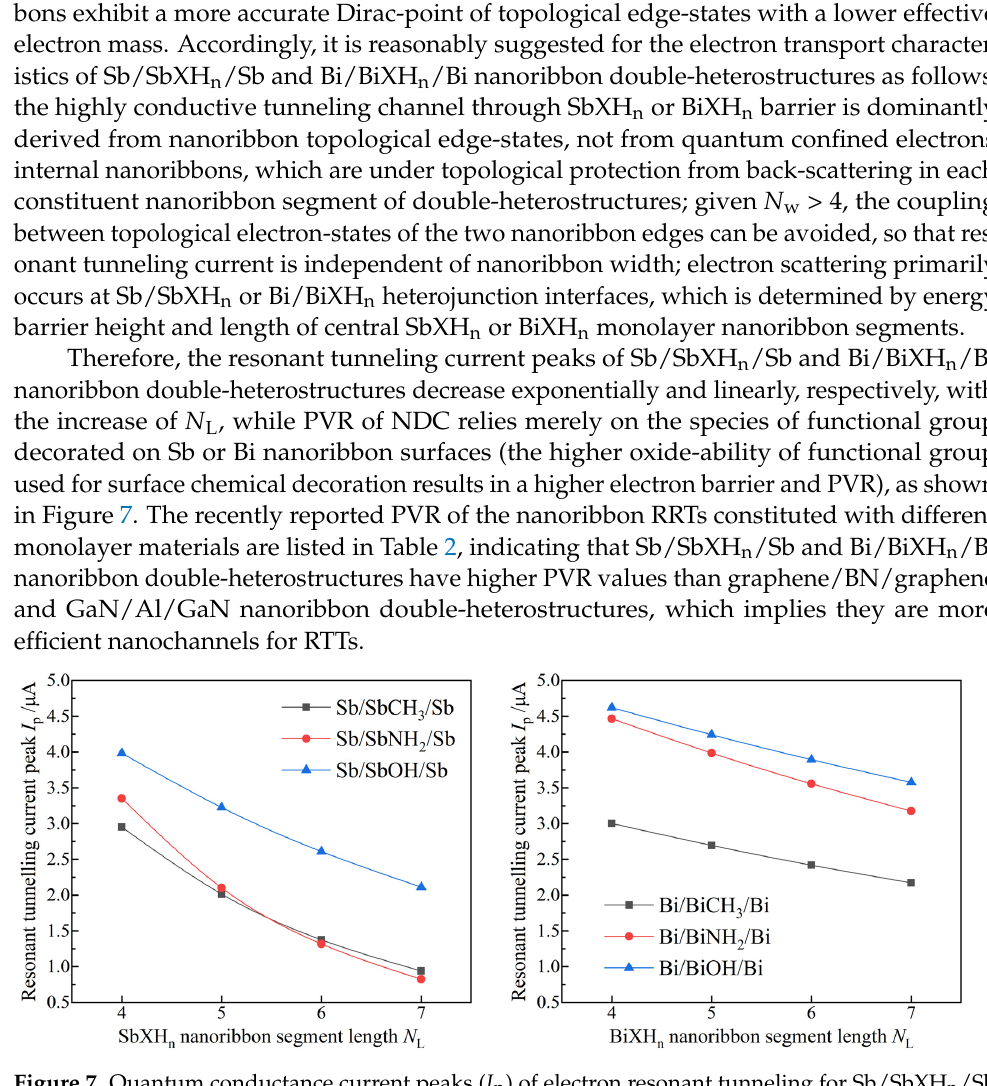
Figure 7. Quantum conductance current peaks ( I p ) of electron resonant tunneling for Sb/SbXH n /Sb ( left panel ) and Bi/BiXH n /Bi ( right panel ) nanoribbon double-heterostructures ( N w = 5) in depen- dence on the length ( N L ) of central SbXH n or BiXH n nanoribbon segments. Table 2. Threshold gate voltage and PVR for resonant tunneling transistors of nanoribbon double-heterostructures constructed by specific 2D monolayer materials.